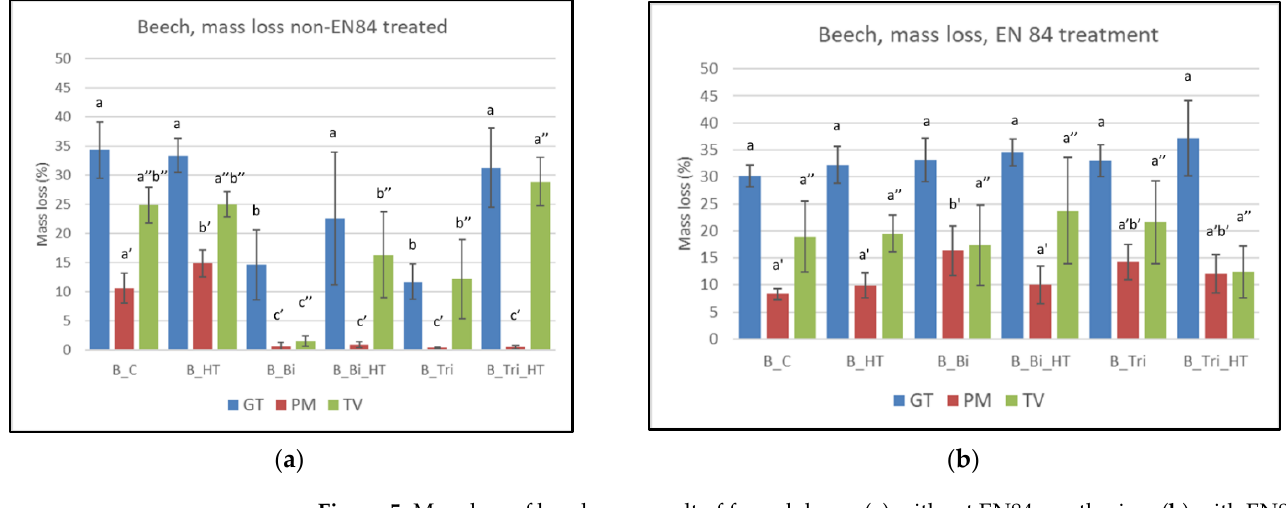
( b ) Figure 6. Mass loss of spruce as a result of fungal decay, ( a ) without EN84 weathering; ( b ) with EN84 weathering. GT— G. trabeum , PM— P. monticola, TV— T. versicolor . Tukey analysis groups shown above each bar graph. ANOVA analysis of results of non-EN84 accelerated ageing of both beech and spruce showed there were significant differences for all the fungi ( p < 0.05). From Figures 5 and 6, it can be seen that the EN84 accelerated ageing of samples had a significant effect on the effectiveness of treatments considered in this study. Whereas the spruce control (S_C) and beech controls resulted in similar levels of decay irrespective of EN84, values for other treatments varied considerably, with the greatest effects noted for treatments of both spruce and beech involving bicine or tricine in non-EN84 tests, particularly when as- sessing with P. monticola . However, decay rates were similar or worse where EN84 ageing was carried out prior to decay studies. Similarly, when spruce underwent decay with G. trabeum with bicine (S_Bi and S_Bi_HT) without EN84, significant decreases in decay were noted, though these were found to result in greater decay rates when EN84 was carried out. A similar effect was noted with beech (B_Bi). In an attempt to ascertain why the non-EN84 treated samples experienced consider- able reduction in decay levels, moisture content assessments were also carried out on these samples. Results (Figures 7 and 8) suggest that the presence of bicine or tricine as